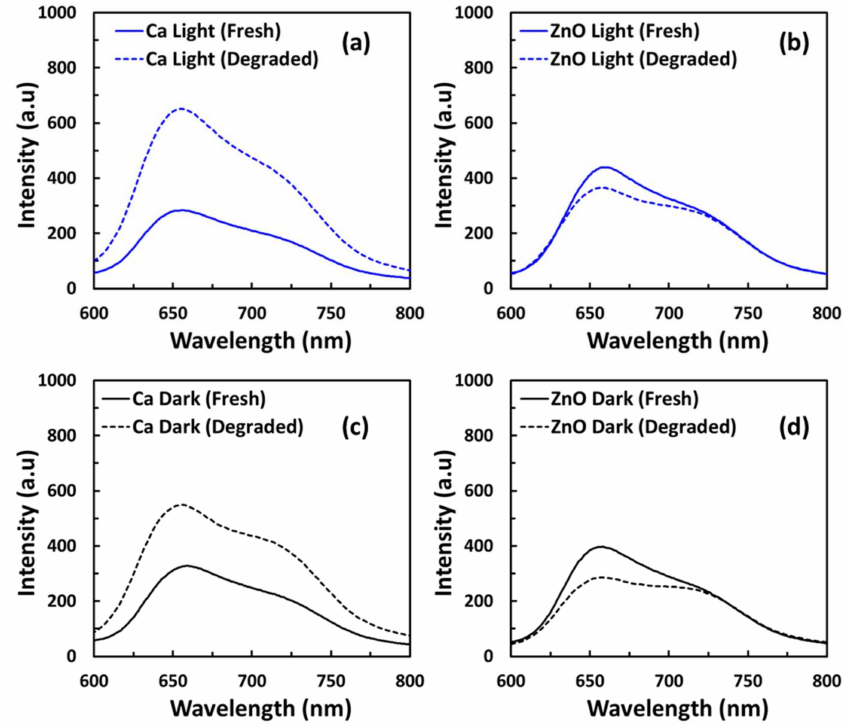
Figure 6. ( a , c ) Photoluminescence spectra of P3HT:ICxA/Ca, and ( b , d ) Photoluminescence spectra of P3HT:ICxA/Ca systems. Solid lines denote fresh devices and dashed line represents degraded devices (blue color means light and black color means dark conditions). The photoluminescence spectra are measured within 2 ◦ C of the reference temperature (25 ◦ C). A 550 nm excitation wavelength was used with luminescence recorded at 200 nm/min scan speed with 1 nm data interval and a 65 ◦ light incident